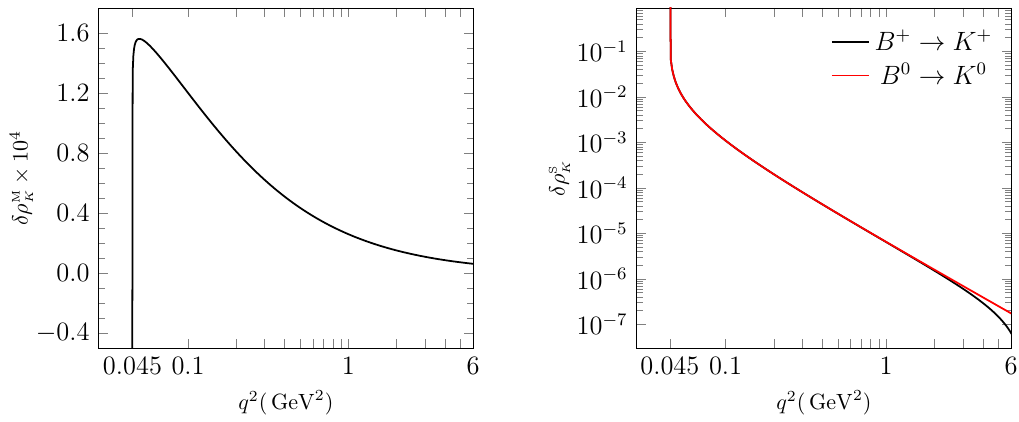
Figure 8 . The (cid:14)(cid:26) M (^ s ) (magnetic-dipole) and (cid:14)(cid:26) S (^ s ) (Sommerfeld) deviations as de(cid:12)ned in the K K text, as a function of q 2 , in the left and right plots respectively. The red and black curves in the right plot stand for the Sommerfeld corrections to the neutral and charged B ! K transitions respectively.